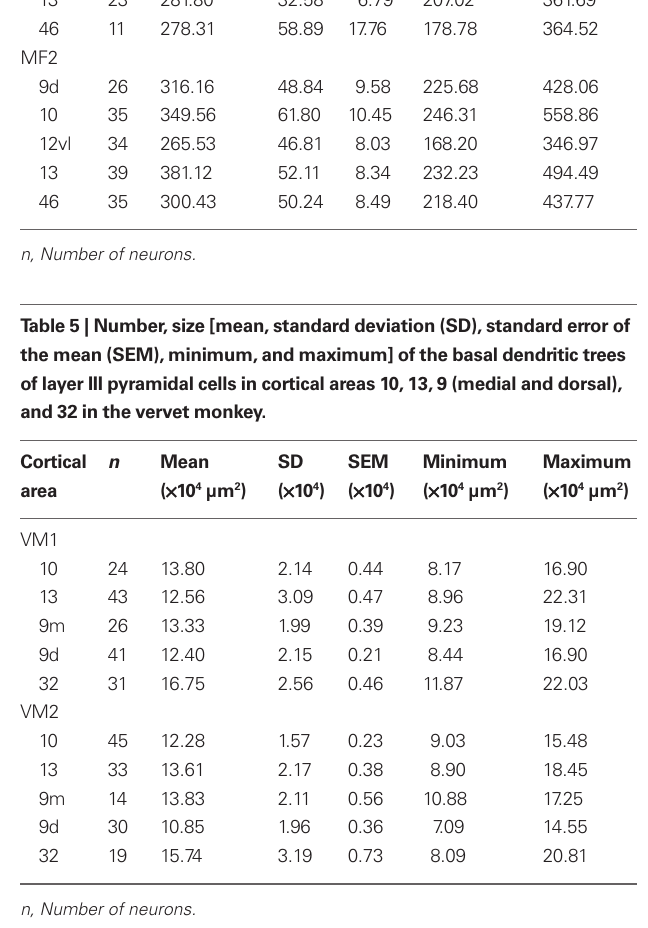
cortical areas in both VM1 ( F Post hoc Scheffe tests revealed that spine density in area 32 was significantly different to that in areas 9d and 9m in VM1